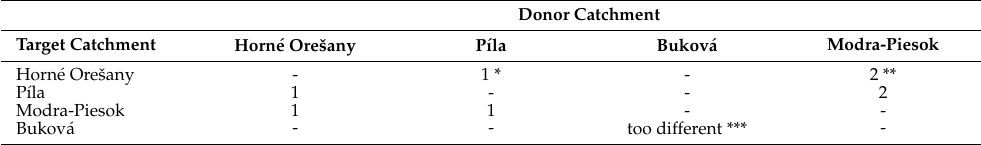
Table 7. Evaluation of best choices of donor